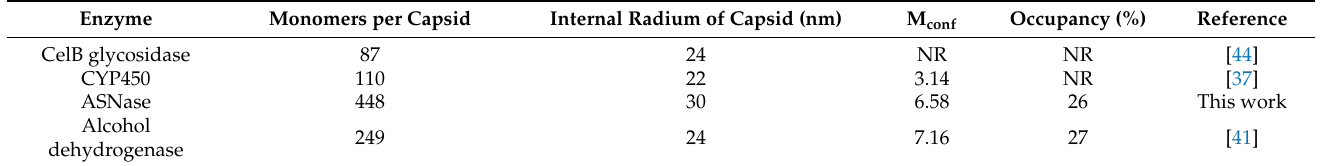
Table 2. Enzymes encapsidated in bacteriophage P22-based